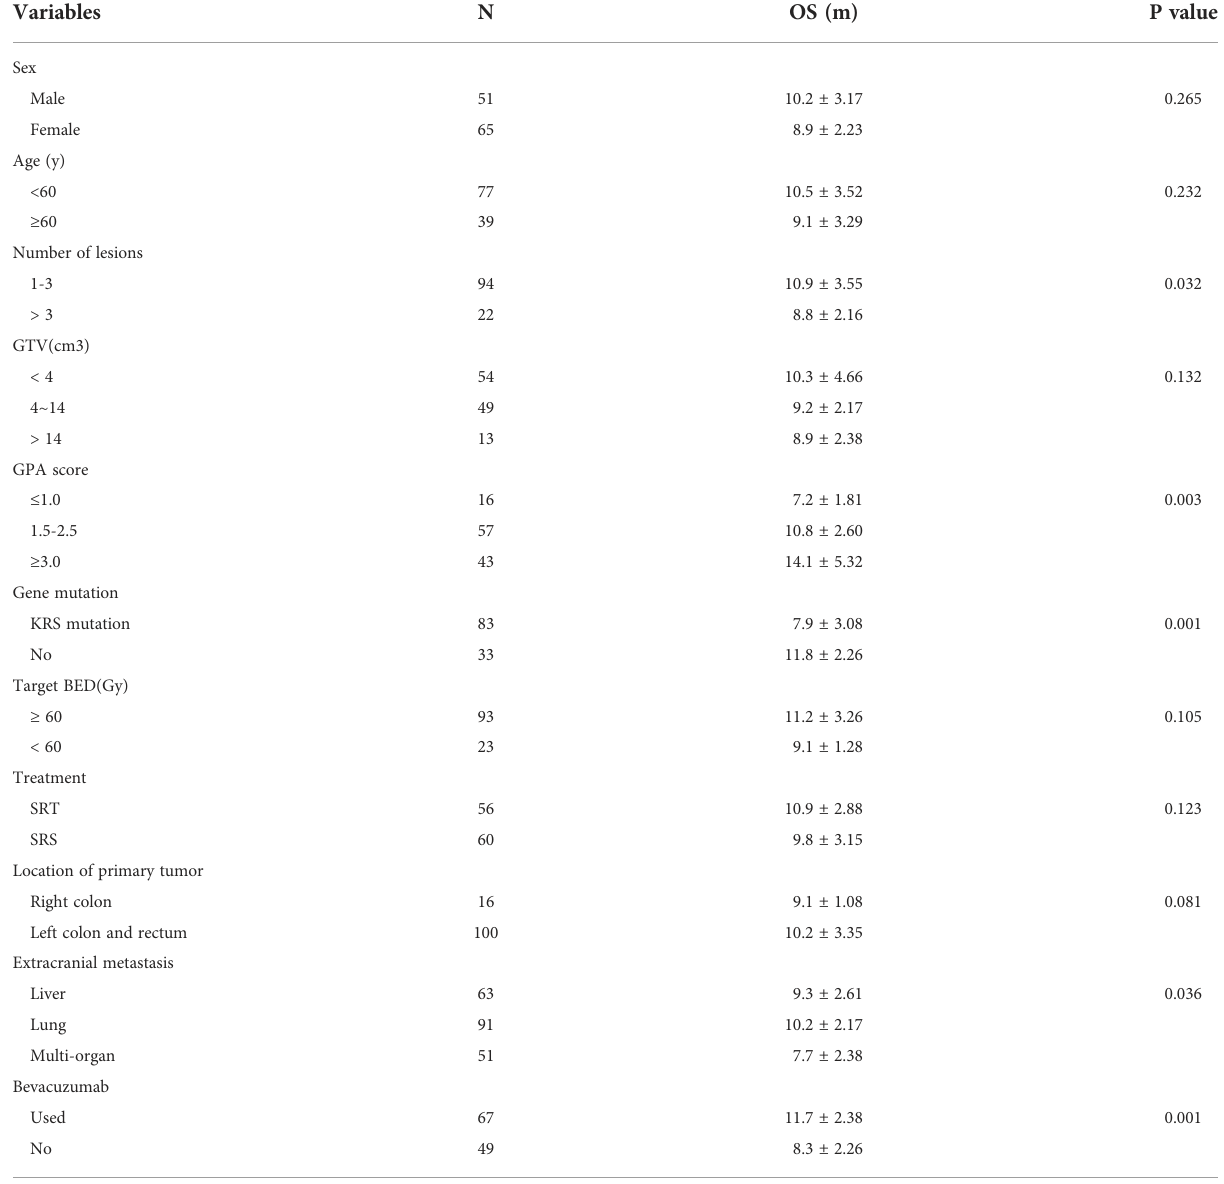
TABLE 2 Univariate analysis of variables predictive of OS.